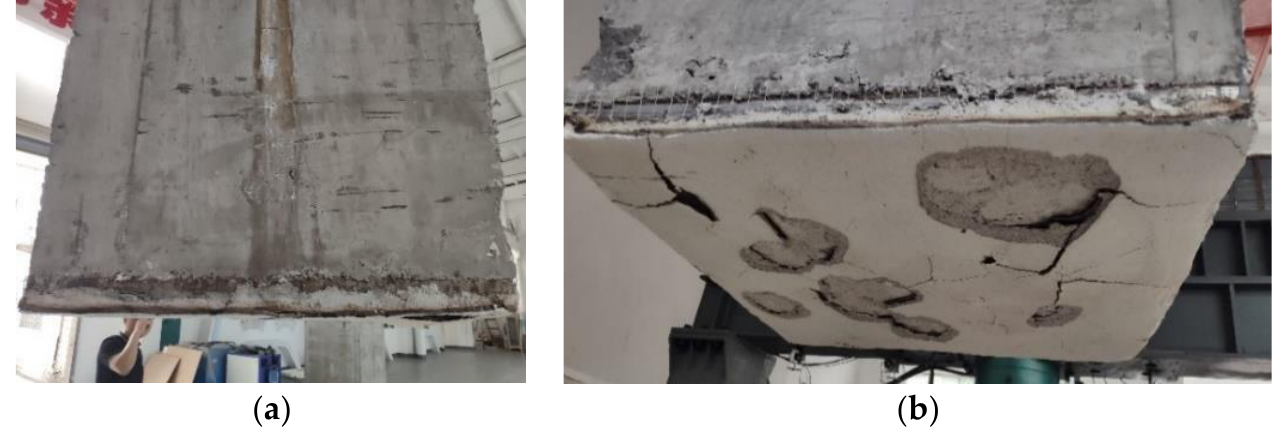
Figure 13. Diagrams of the first fireproof coating insulation test. ( a ) The front view of the member after the fireproof coating caught fire; ( b ) diagram of the fireproof coating damage. After the test, the producer made improvements to the fireproof coating construction method and coating material, and a second fireproof coating insulation test was conducted (Figure 14a). The test was terminated after the temperature of the side-1-bottom